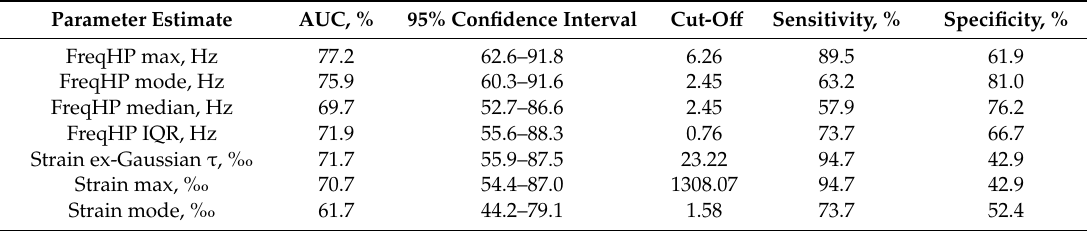
Figure 1. Displacement parameter estimate comparisons between healthy controls and patients with Alzheimer’s disease (AD): ( a ) strain and ( b ) frequency of high-end spectra peak (FreqHP). AD patients had a longer exponential tail of strain distribution (as evaluated by ex-Gaussian distribution τ and maximum estimates), FreqHP (as evaluated by mode, median and maximum estimates), and a higher variability of FreqHP (as evaluated by interquartile range (IQR) estimate). Boxplots represent median (midline of box), Q1 and Q3 (lower and upper side of box, respectively); whiskers are no greater than 1.5 × IQR. P values are according to the Mann–Whitney test; n.s. = non-significant di ff erences. Table 1. Receiver operating characteristic (ROC) analysis of variables that achieved p ≤ 0.05 using a Mann–Whitney test or were used in logistic regression